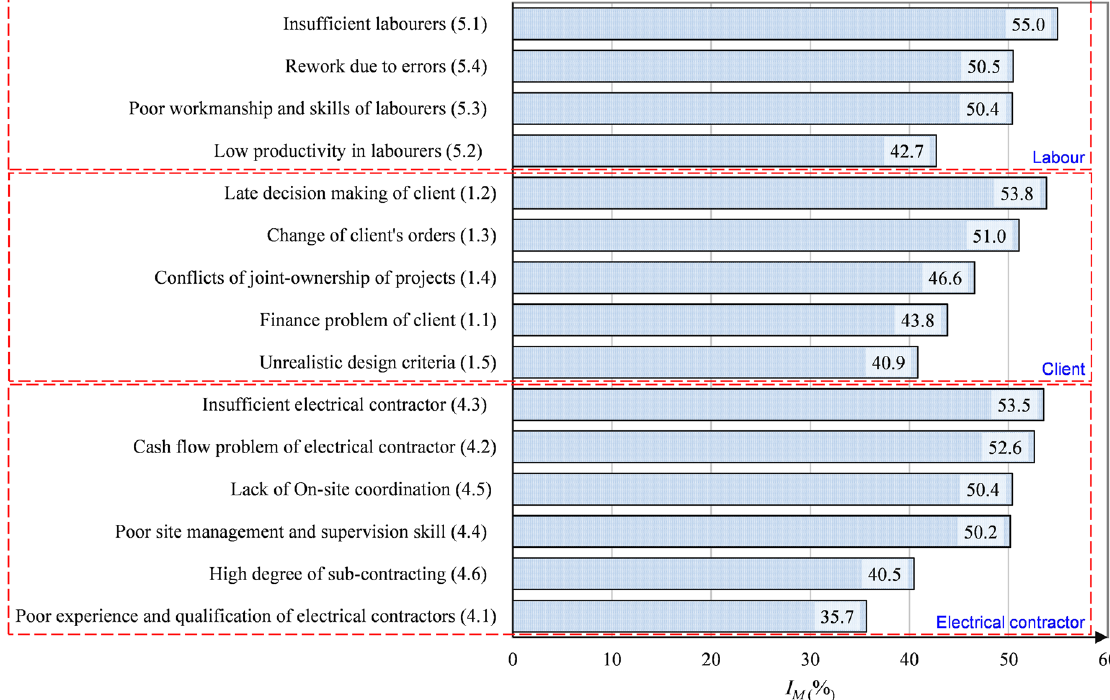
Fig. 2. Importance indices of factors in the top 3 factor